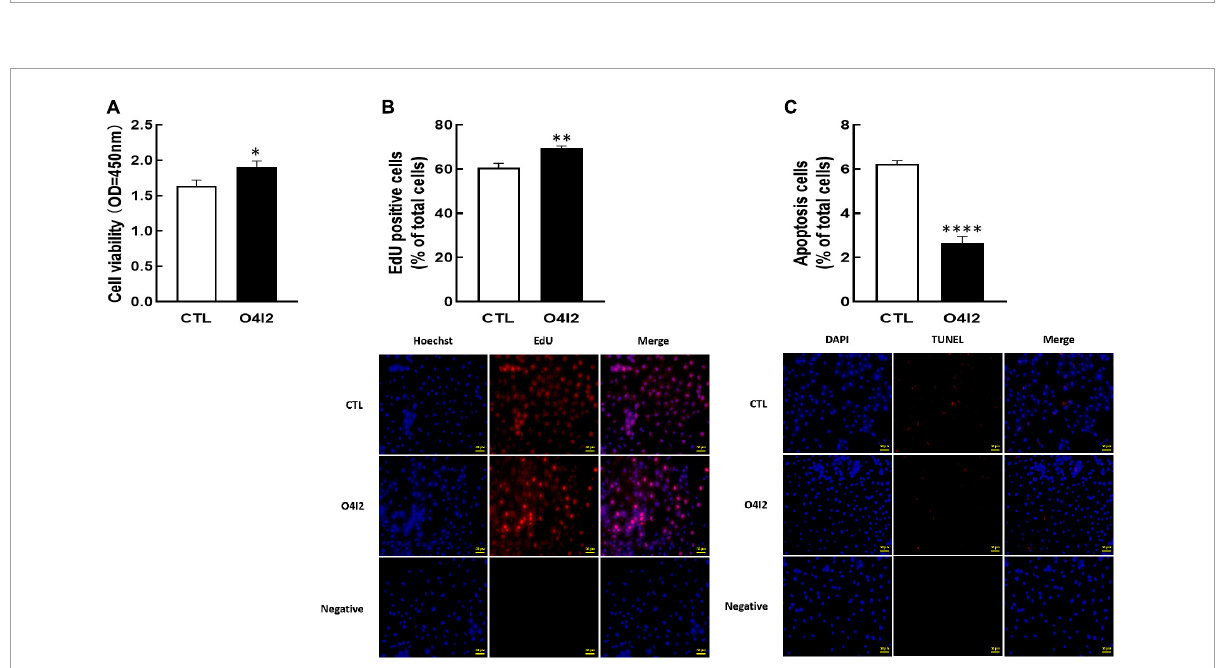
FIGURE4 Effect of OCT4 activator (O4I2) on cellular development in KGN cells. The cells were treated with O4I2 (12.5 µ M) for 24 h and then CCK-8 assay, EdU and TUNEL measurement were used for detecting cell viability (A) , proliferation (B) , and apoptosis (C) . Data are presented as mean ± SEM of three independent experiments. ∗ P < 0.05, ∗∗ P < 0.01, ∗∗∗∗ P < 0.0001 compared with CTL. Bar = 50 µ